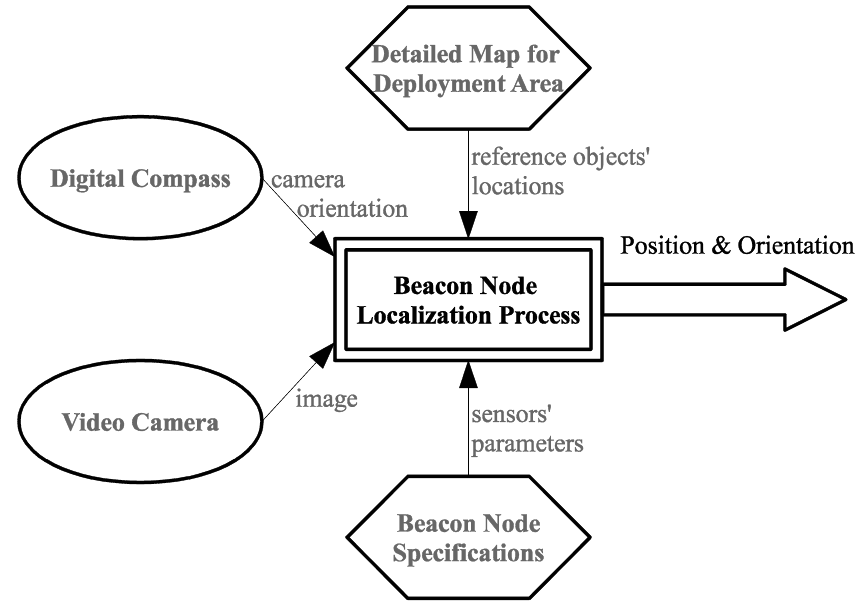
Figure 1. Information sources used in our beacon node localization